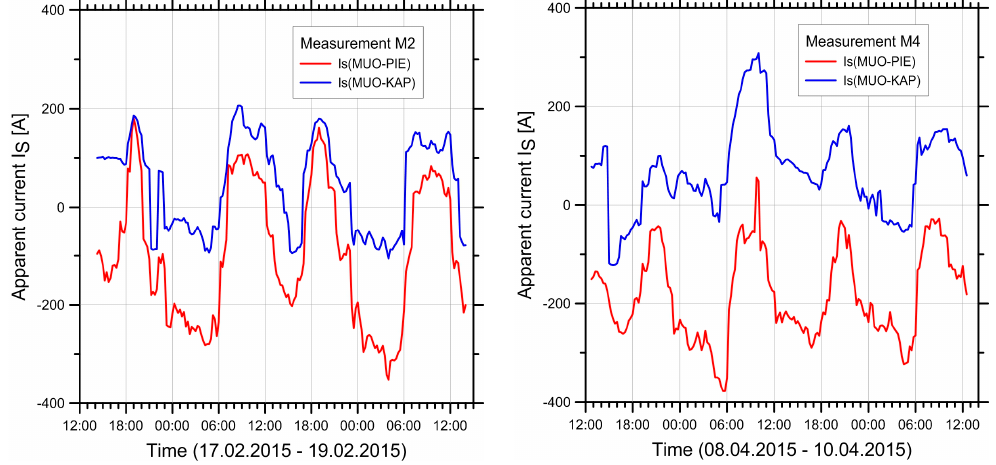
Figure 9. Plots of the apparent current I S in the two circuits MUO-PIE (Mühleberg-Ost to Pieterlen) and MUO-KAP (Mühleberg-Ost to Kappelen) during measurement periods M2 ( left ) and M4 ( right ) in Wiler.